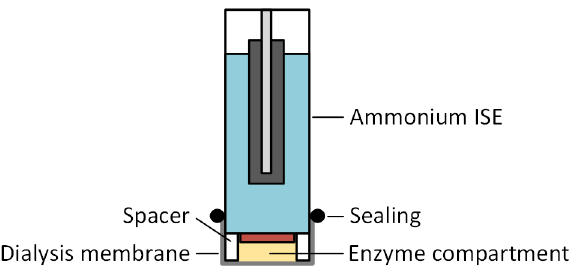
Figure 3. Schematic cross section of the urea sensor, consisting of an ammonium ISE with an additional 0.5mm spacer, and a dialysis membrane that forms the enzyme